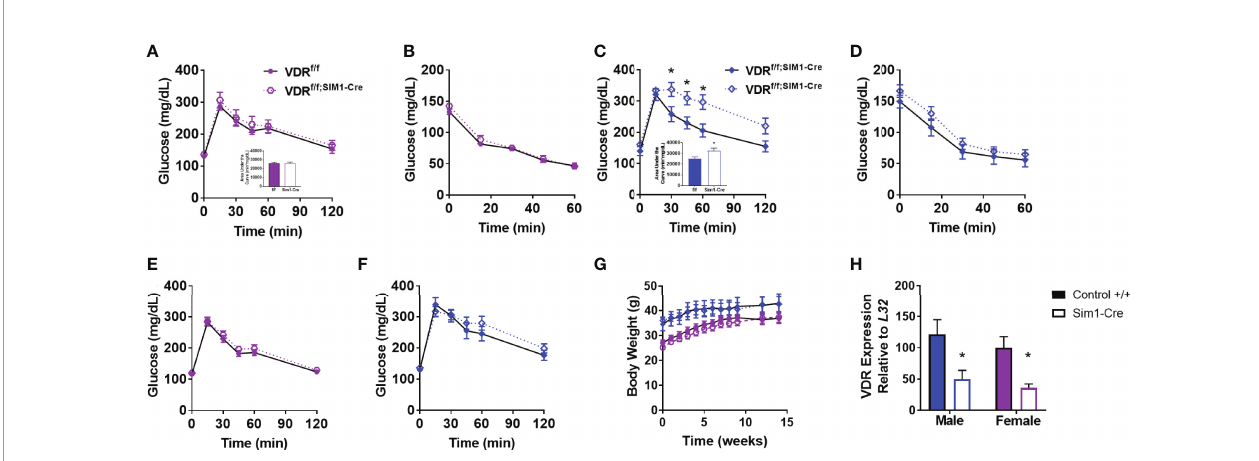
FIGURE 2 | Genetic PVH VDR knockdown impairs glucose and insulin tolerance in males but not females. (A, B) Glucose tolerance (A) and area under the curve (inset) in 26-29 week old DIO female mice. (B) Insulin tolerance test in 30-33 week old DIO female mice. (C) Glucose tolerance test (C) and area under the curve (inset) in 30-33 week old DIO male mice. (D) Insulin tolerance test in 34-37 week old DIO male mice. (E) Glucose tolerance test in chow-fed female mice (18-21 weeks of age). (F) Glucose tolerance test in chow-fed male mice (22-25 week old). (G) Body weight trajectories of female and male mice after starting high-fat diet. (H) VDR mRNA expression in upper hypothalamus of male and female mice. N=8-14/gp for (A – G) and 4-6/gp for (H) Open shapes represent Cre+ mice; closed shapes represent control mice. *p<0.05 compared to same-sex